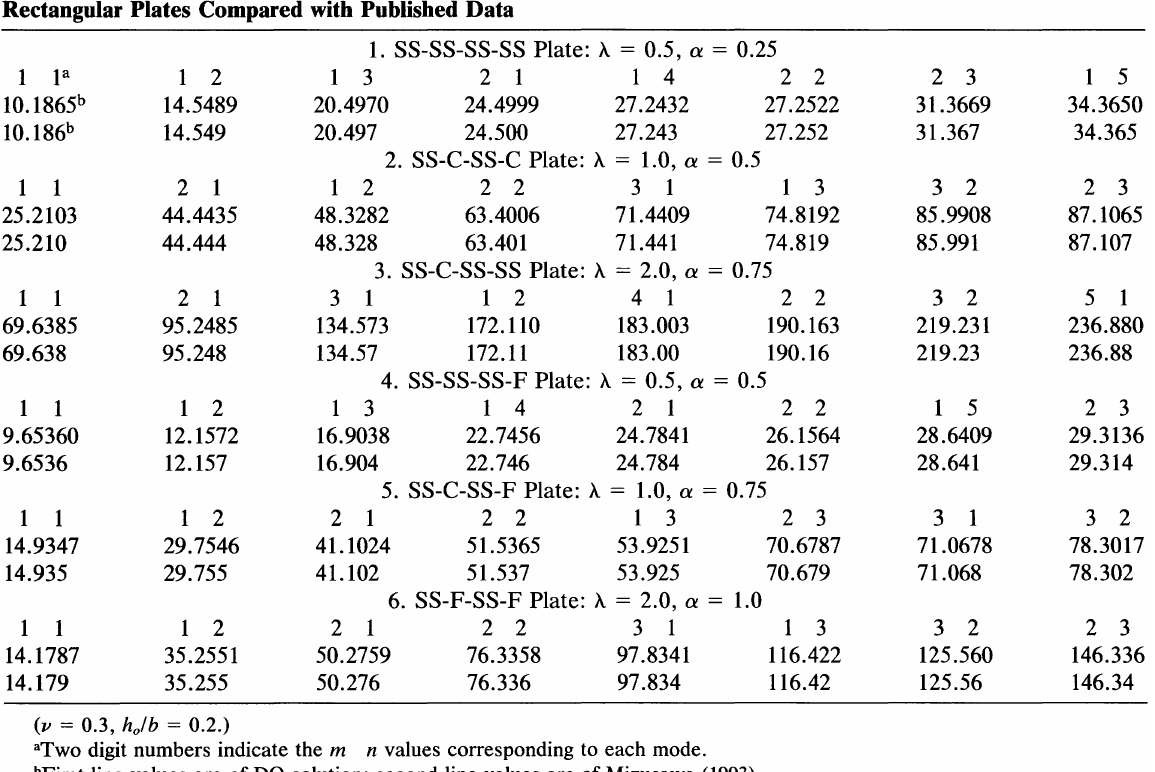
Table 4. Accuracy of Semianalytical DQ Solution: First Eight Free Vibration Frequencies of Thick Isotropic Rectangular Plates Compared with Published Data